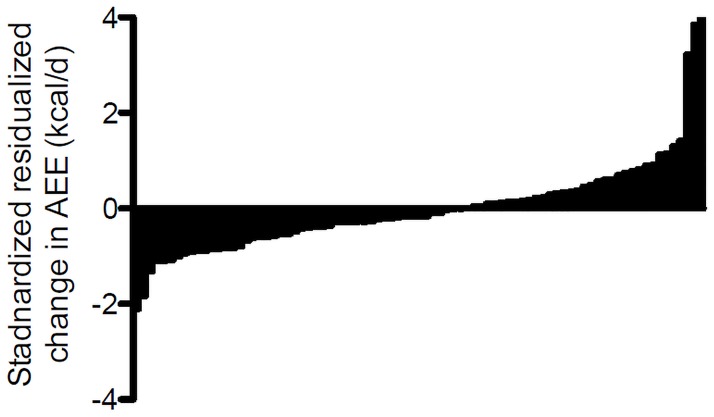
Distribution of follow-up AEE values adjusted for baseline.Values are AEE residuals after regression baseline AEE on follow-up AEE. Values are standardized to a mean of zero.